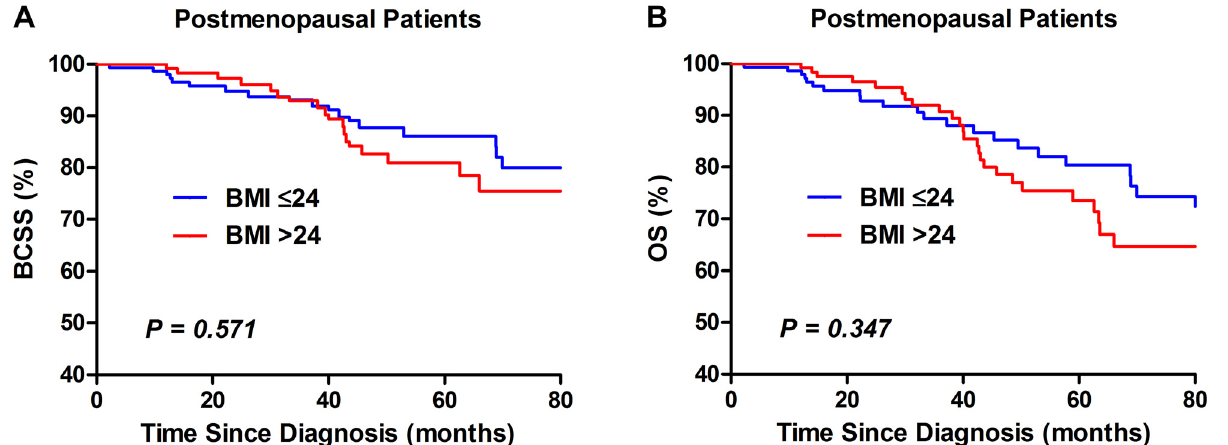
Fig 3. Kaplan – Meier curves of BCSS (A) and OS (B) by BMI groups in postmenopausal TNBC patients.